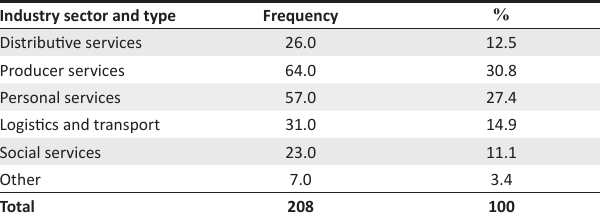
TABLE 8: Characteristic four: Industry sector type affiliation of respondents.